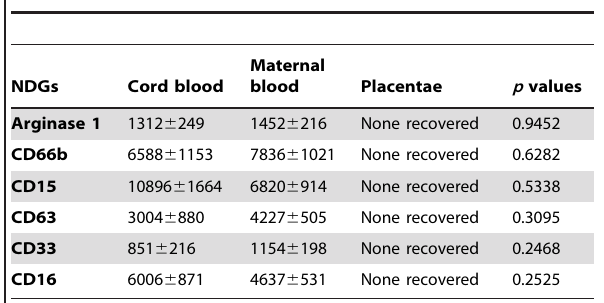
Table 4. Comparison of expression levels of arginase and phenotypic markers of NDGs in placentae, cord and maternal blood.